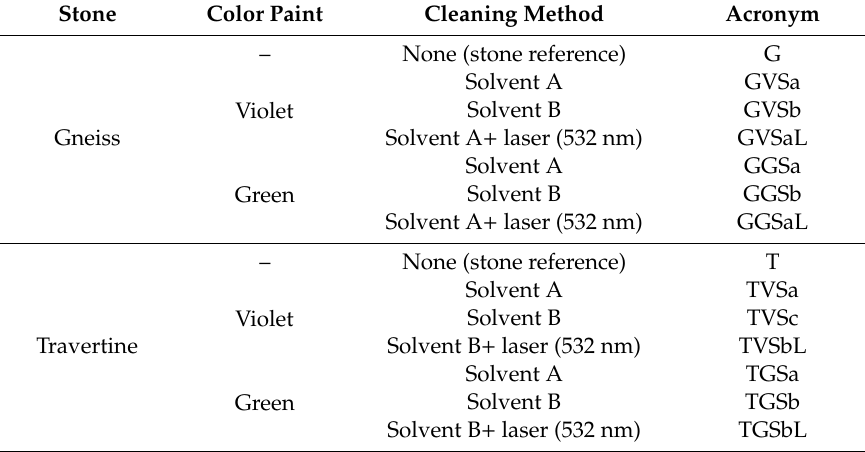
Table 3. Samples set up for cleaning tests in the present work. Acronyms for each sample are listed (the first letter indicating the type of stone, the second letter the type of gra ffi ti paint and the following the cleaning treatment